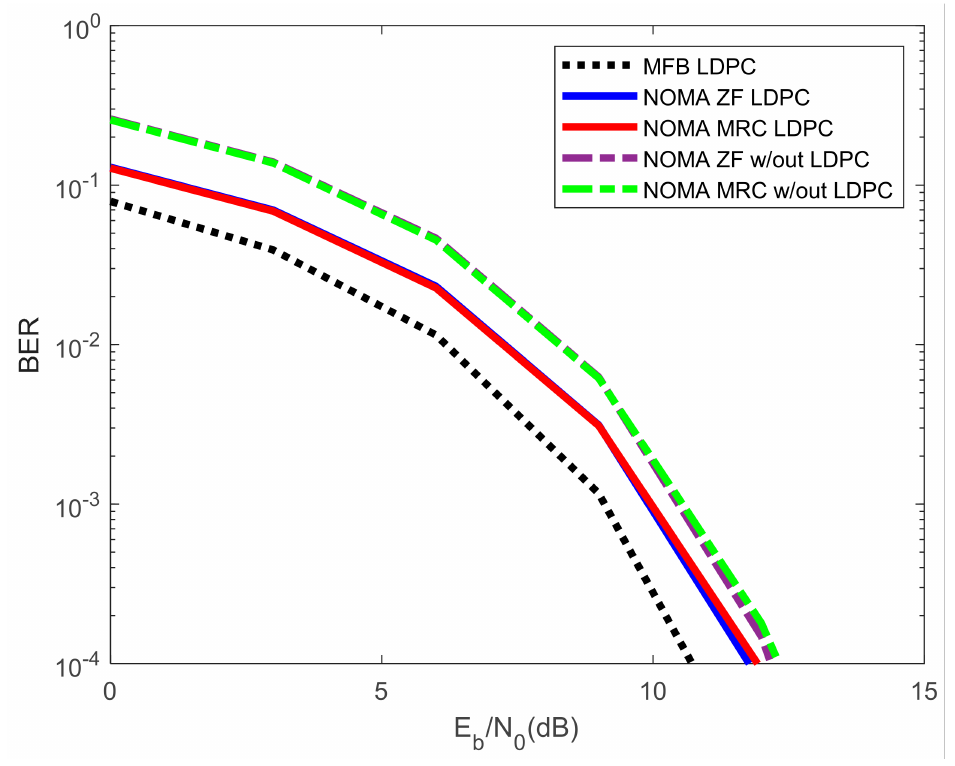
Figure 4. Results for 2 NOMA users with powers [0.5, 1], with 8 × 64 MIMO (with and without LDPC